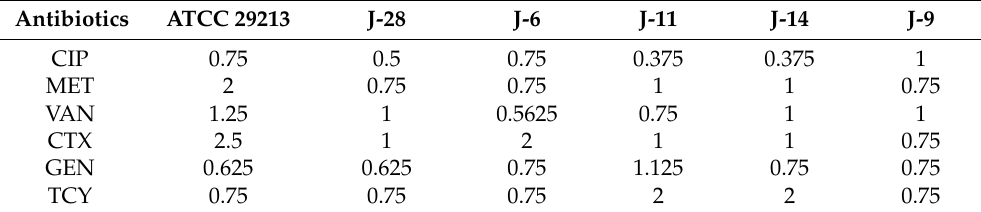
Table 3. Fractional inhibitory concentration index of piceatannol combined with different antibiotics against Staphylococcus aureus